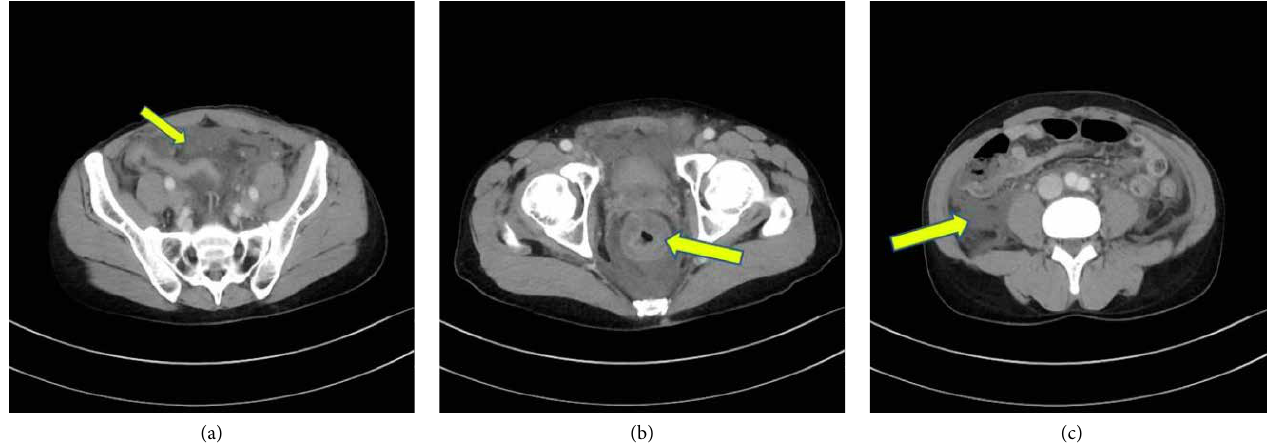
Figure 1: Abdominal computed tomography findings in a patient with primary peritonitis. (a) Computed tomography indicated a small amount of ascites. (b) Computed tomography showed edema of the intestinal membrane. (c) Computed tomography showed edema of the